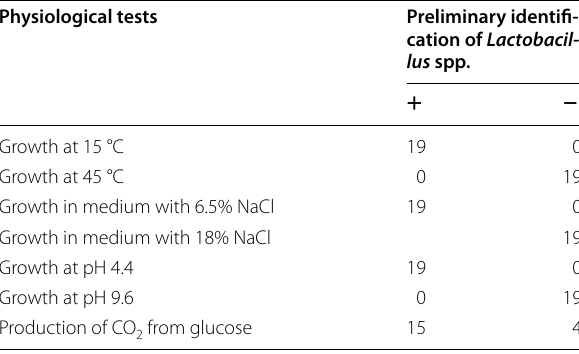
Table 3 Physiological characteristics and